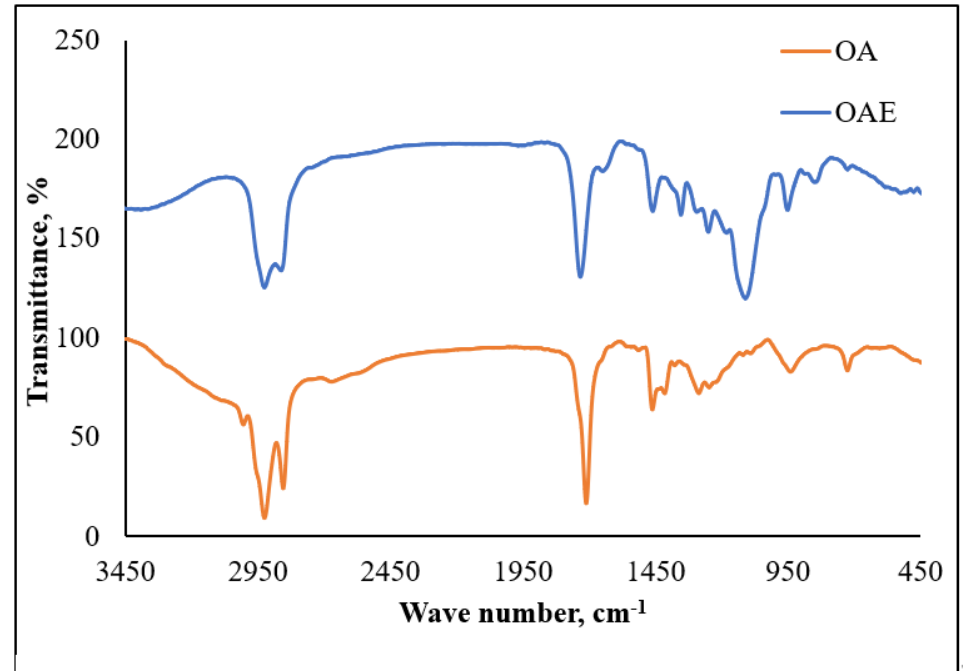
Figure 7. FTIR of oleic acid (OA) and oleic acid ethoxylate (OAE).